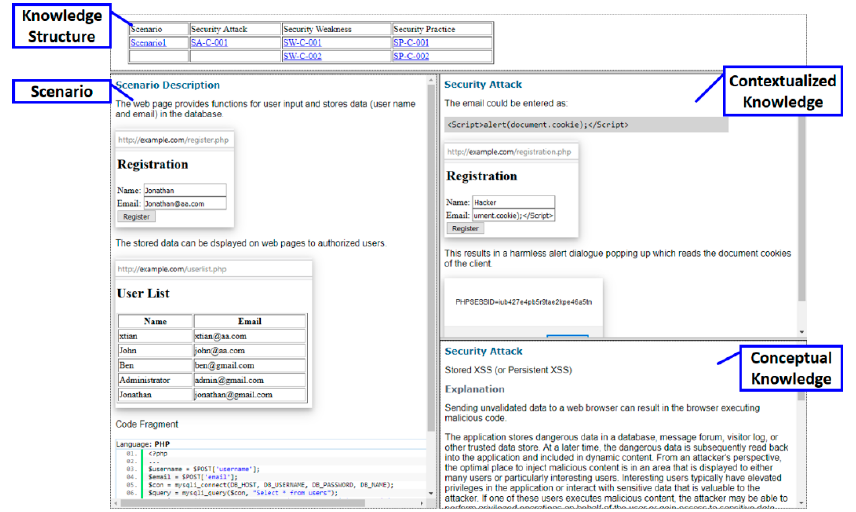
Figure 12. The user interface for security knowledge presentation.